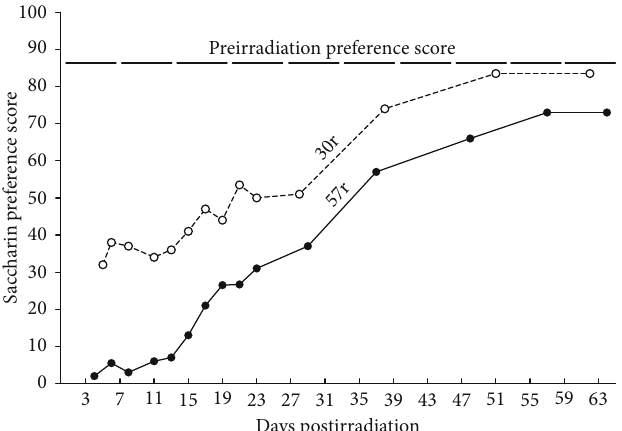
Figure 2: Median saccharin preference scores for animals previously given saccharin access during radiation exposure. Redrawn from Garcia et al.